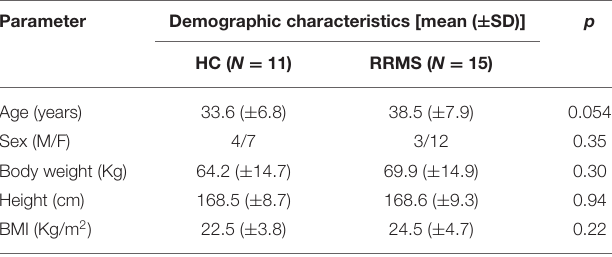
TABLE 1 | Demographic characteristics of all study